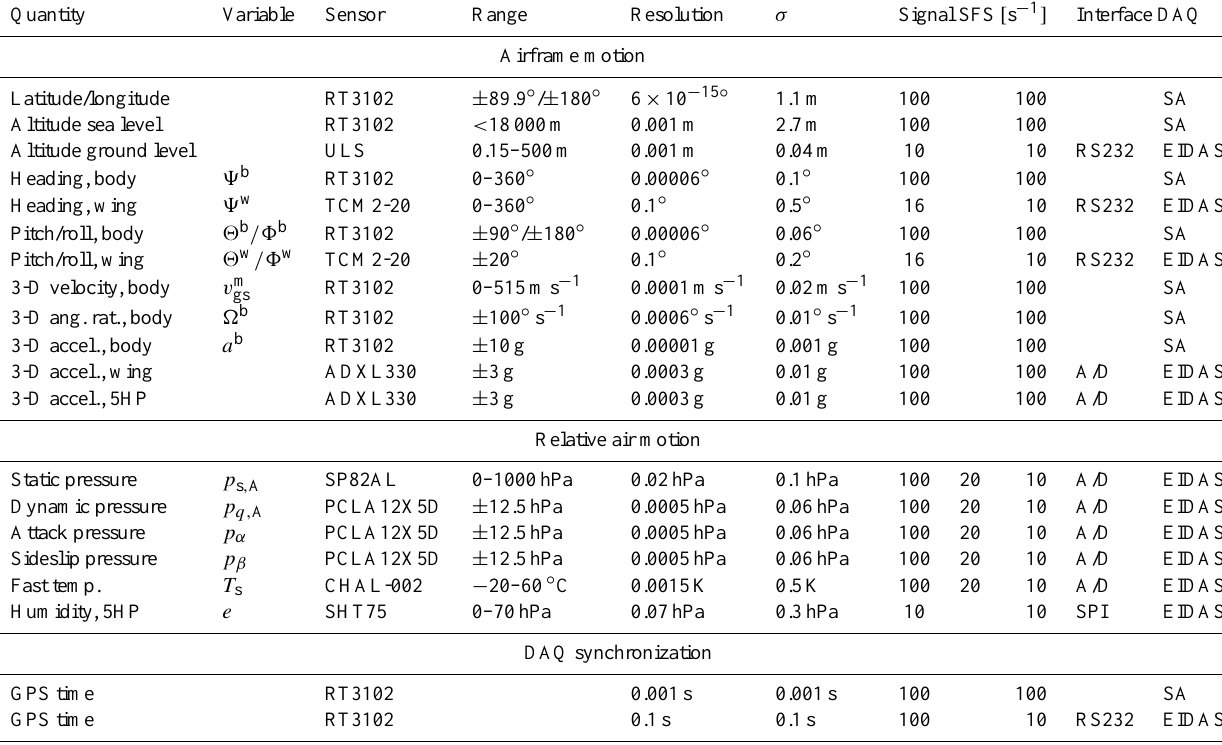
Table 2. List of measured variables, sensor characteristics, signal processing and data acquisition. Individual sensor locations are described in Sect. 2.2 and displayed in Figs. 1 and 3. Resolution refers to the smallest change registered by the data acquisition (DAQ) units. σ is the overall sensor uncertainty provided by the manufacturer in form of one standard deviation. Signal rates are displayed for sampling, filtering and storing (Signal SFS). Data acquisition takes place in two forms, standalone (SA) and on the central DAQ unit EIDAS. For non SA devices signal forwarding via A/D converter, recommended standard 232 (RS232) or serial peripheral interface (SPI) is indicated (Interface DAQ). Continued on next